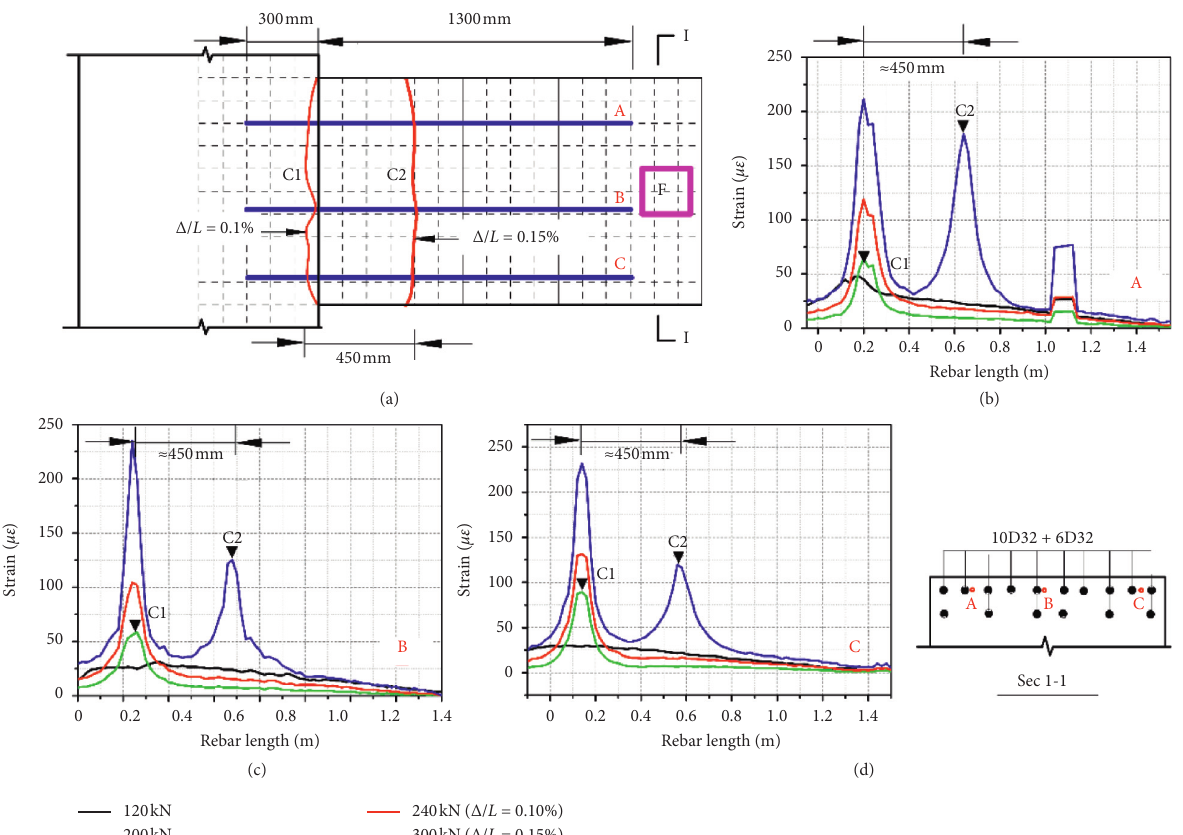
Figure 7: Damage status at 0.15% drift (a) and strain profile measured in top fibers A, B, and C at drift levels below 0.15% ((b), (c), and (d)).